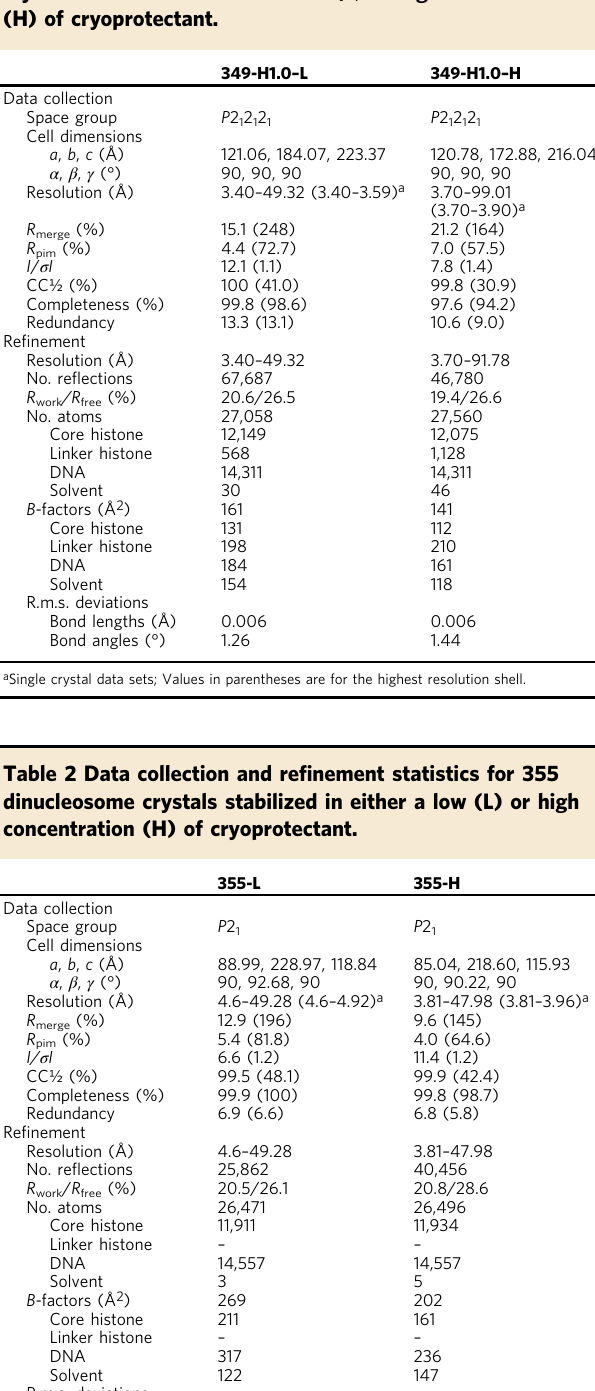
Table 3 Data collection and re fi nement statistics for 349 dinucleosome and 355 dinucleosome assembled with linker